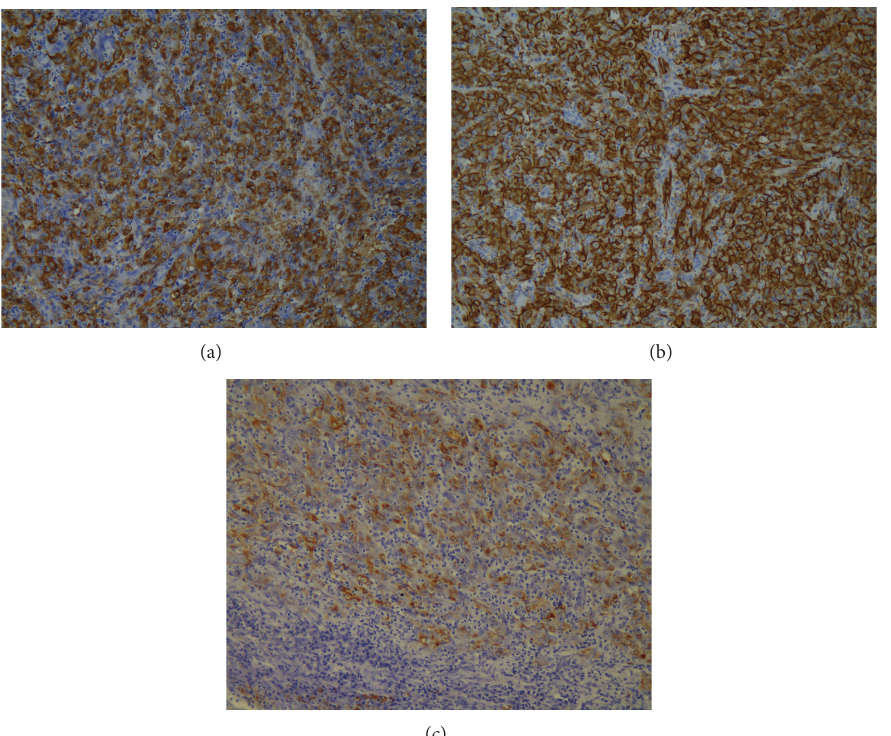
Figure 2: (a) Angiosarcoma cells show positivity for CD31 antigen (monoclonal mouse clone JC70A—Dako—40x). (b) Factor VIII-related antigen positivity in the angiosarcoma cells (policlonal rabbit—DAKO—40x). (c) Tumor cells express partially pancytokeratin (CK-) related antigen (cytokeratin monoclonal mouse clone